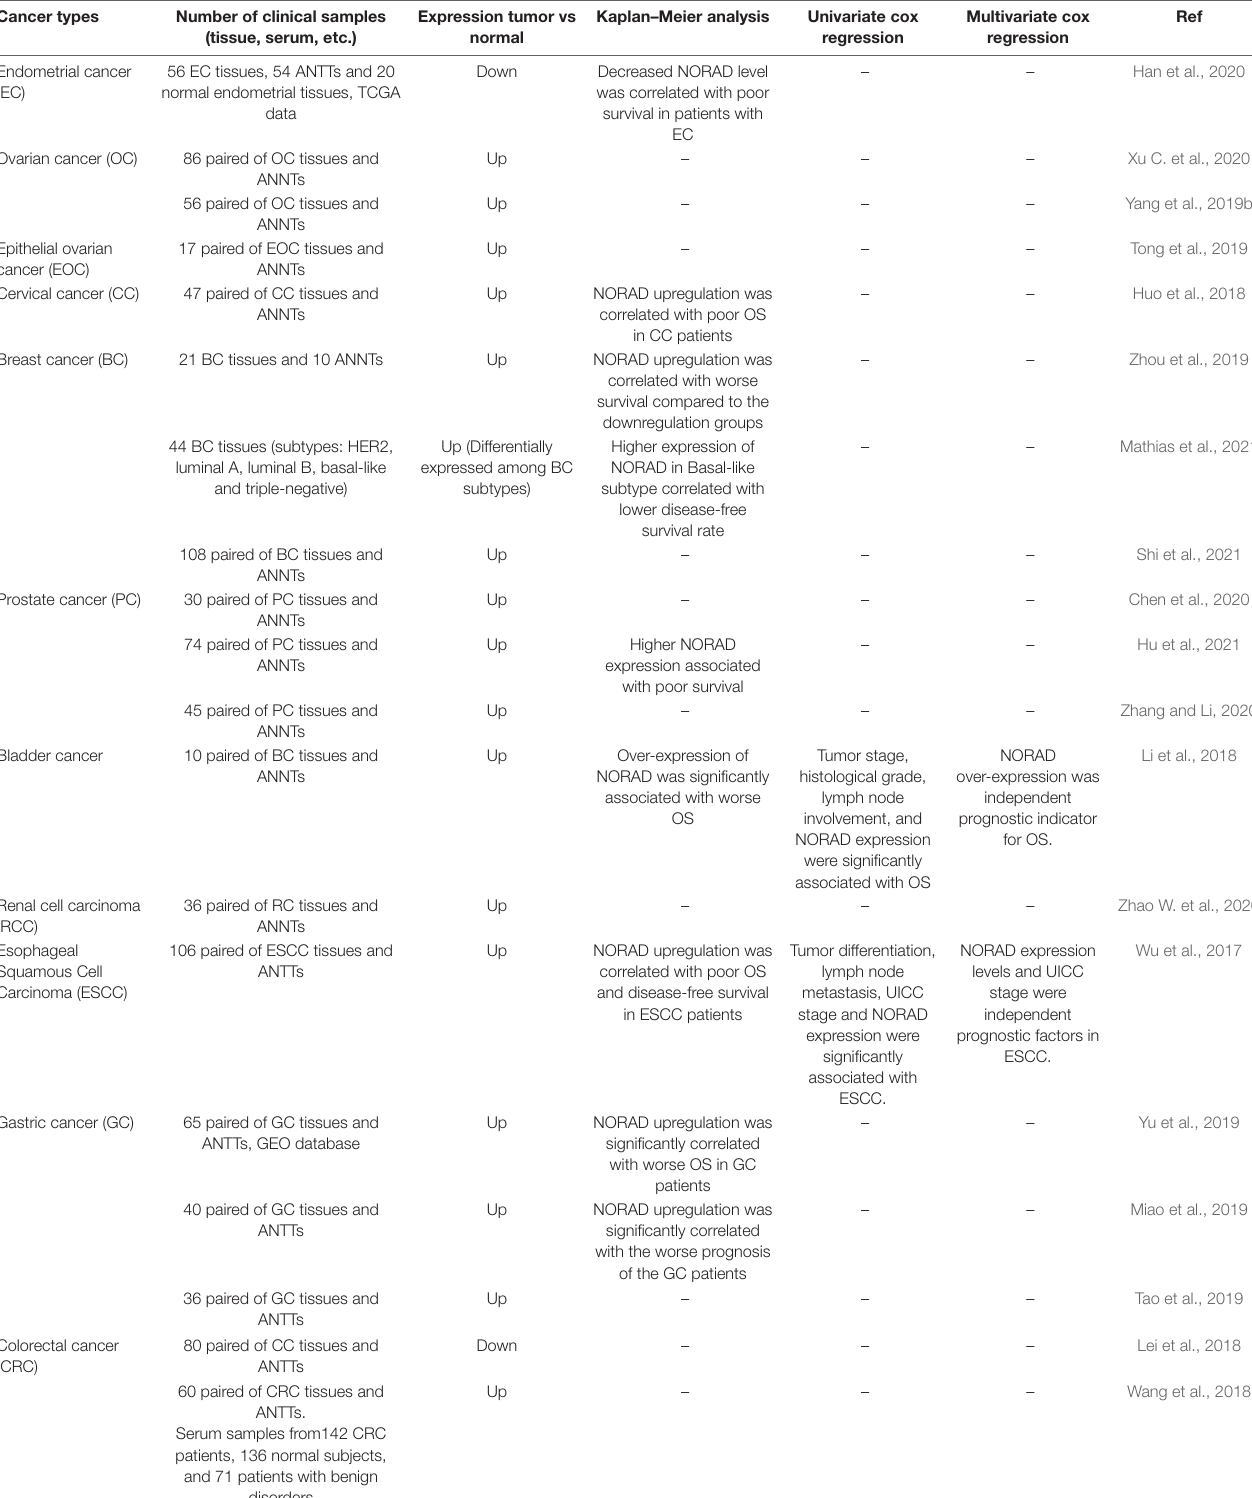
TABLE 2 | Summarized results of studies which assessed expression of NORAD in clinical samples (OS: overall survival, ANTT: adjacent non-tumoral tissue). Cancer